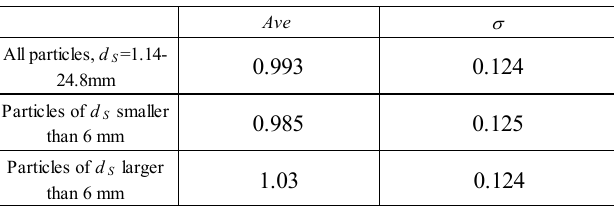
> for the database by S